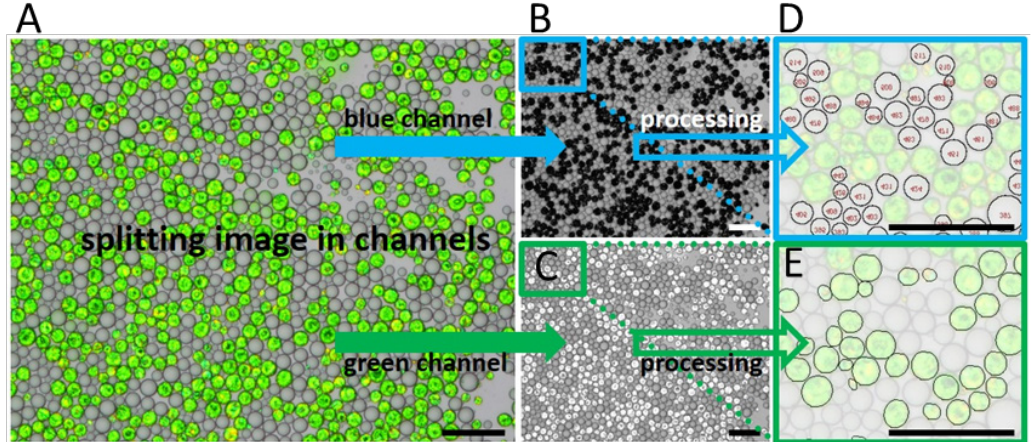
Figure 2. ( A ) shows the original image of 1 wt % hexadecane in Milli-Q water emulsion stabilized with 1 wt % Tween ® 20 at 4.7 °C. Gray transparent spheres are liquid, supercooled droplets and green opaque spheroids are multi crystalline structures of solidified hexadecane droplets. ( B ) shows the blue channel of the original image and ( C ) shows the green channel of the original image. ( D ) shows the processed blue channel image with the resulting determination of supercooled droplets by number and area. ( E ) shows the processed green channel image with the resulting determination of crystallized droplets by number and area. Droplets/particles on the edge of the image were excluded from the characterization. Length of the scale bar is 100 µm.